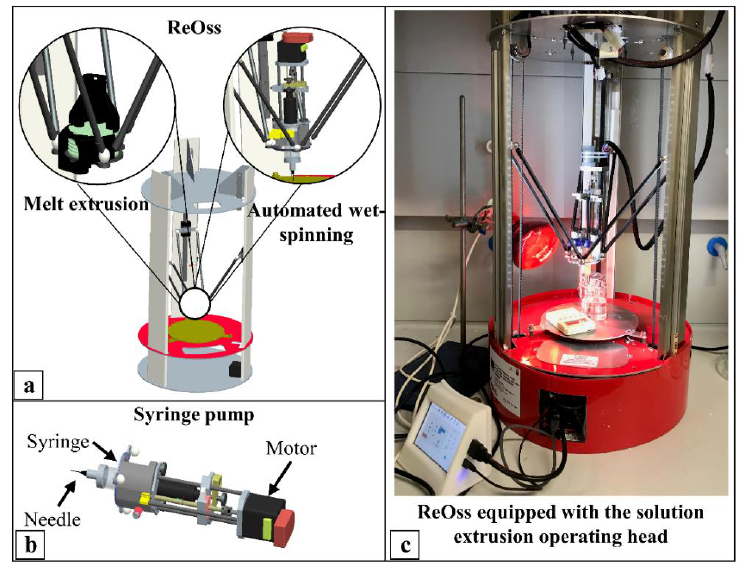
Figure 1. Additive Manufacturing (AM) equipment: ( a ) schematic representation of the AM system and the two switchable operating heads to employ either melt-extrusion or solution-extrusion AM, i.e., Computer-Aided Wet-Spinning (CAWS); ( b ) schematic representation of the CAWS extrusion head employed in this study, showing the syringe equipped with a blunt-tip needle and housed in a feed-controlling pump; ( c ) representative picture of the ReOss apparatus equipped with the syringe pump for CAWS processing (the lamp in the background was employed to control the temperature of the syringe and the coagulation